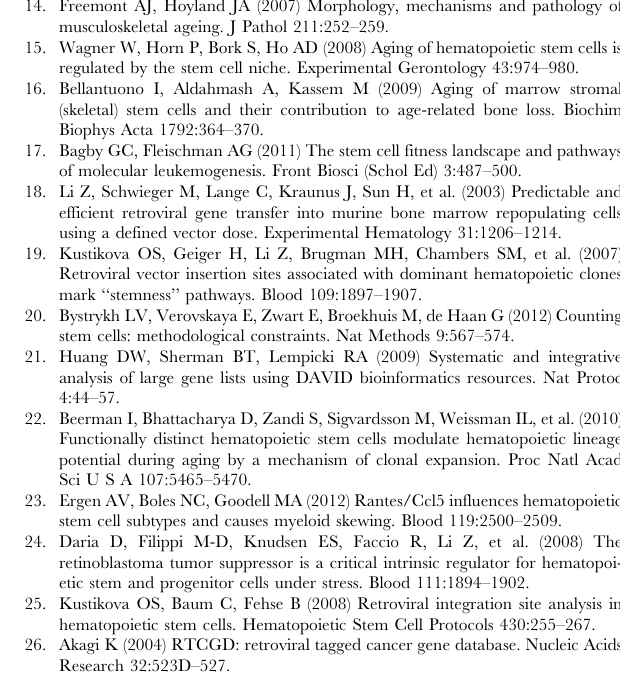
from old recipients were found in IDDb. This efficiency to recover already described viral integration sites supports the validity of our approach. *= insertion sites belong to the dominant